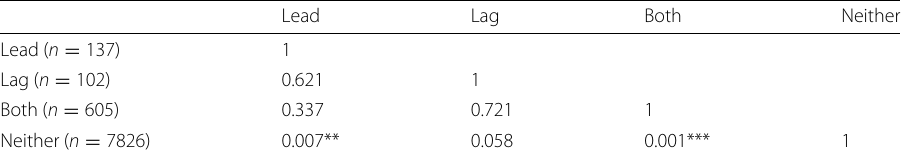
Table 1 The results of the Kruskal-Wallis H-test performed for each pair of groups. Adjusting for multiple comparison, the 10%, 5% and 1% significance thresholds are 0.016, 0.008 and 0.0016 respectively Lead Lag Both